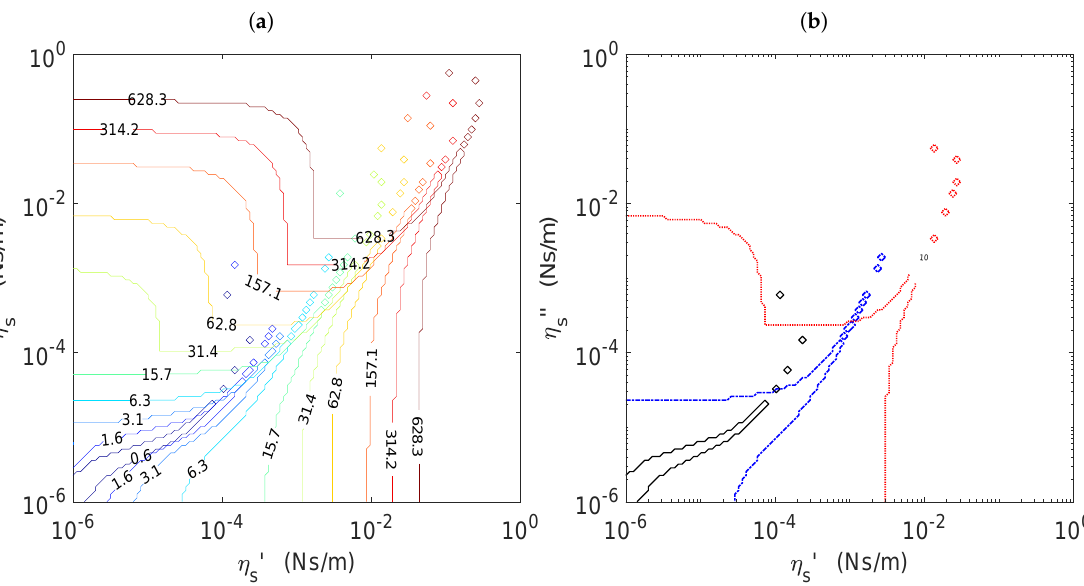
Figure 6. Boundaries separating the regions of the ( η (cid:48) s , η (cid:48)(cid:48) s ) plane where the interface can be distinguished from a clean air–water interface, under the fulfillment of both conditions in Equation (9). ( a ) Lines at frequencies indicated by the line labels in the frequency range 0.63 ≤ ω ≤ 628.32 rad/s. ( b ) Lines at representative frequencies: ω = 0.63 rad/s (black continuous line), ω = 6.28 rad/s (blue dash-dot line), and ω = 62.83 rad/s (red dotted